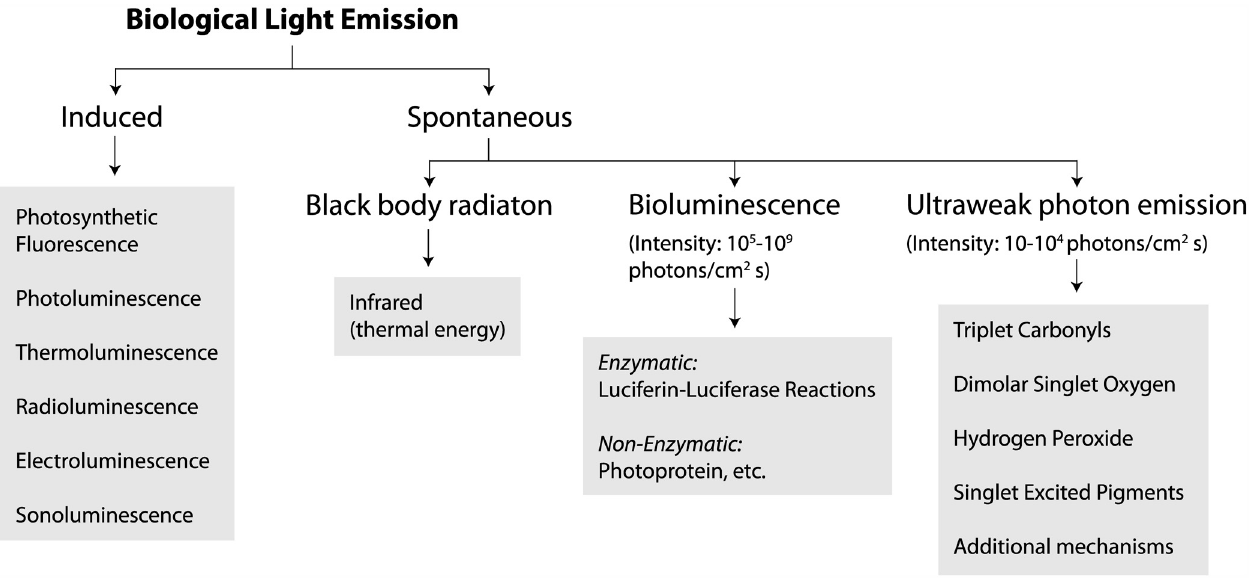
Fig 4. The classification of biological light emission [18 – 24]. There are two groups of light emissions from biological systems: induced and Spontaneous. In the induced light emission there should be an external excitation such as electric filed, light, heat, ultrasound, etc. But the spontaneous light emission does not need any external excitation and it is classified into three subgroups: Blackbody radiation, Bioluminescence and UPE. The sources in the three subgroups are different. The blackbody radiation at room temperature is in the infrared range and hence it cannot activate visual pigments. The intensity (or rate) of bioluminescence (i.e. 10 5 − 10 9 photons/cm 2 s) is much higher than the intensity of UPE (i.e. 10 – 10 4 photons/cm 2 s). The rate of retinal discrete dark noise is in the rate range of UPE. UPE is mostly in the visible range that can activate the visual pigments.